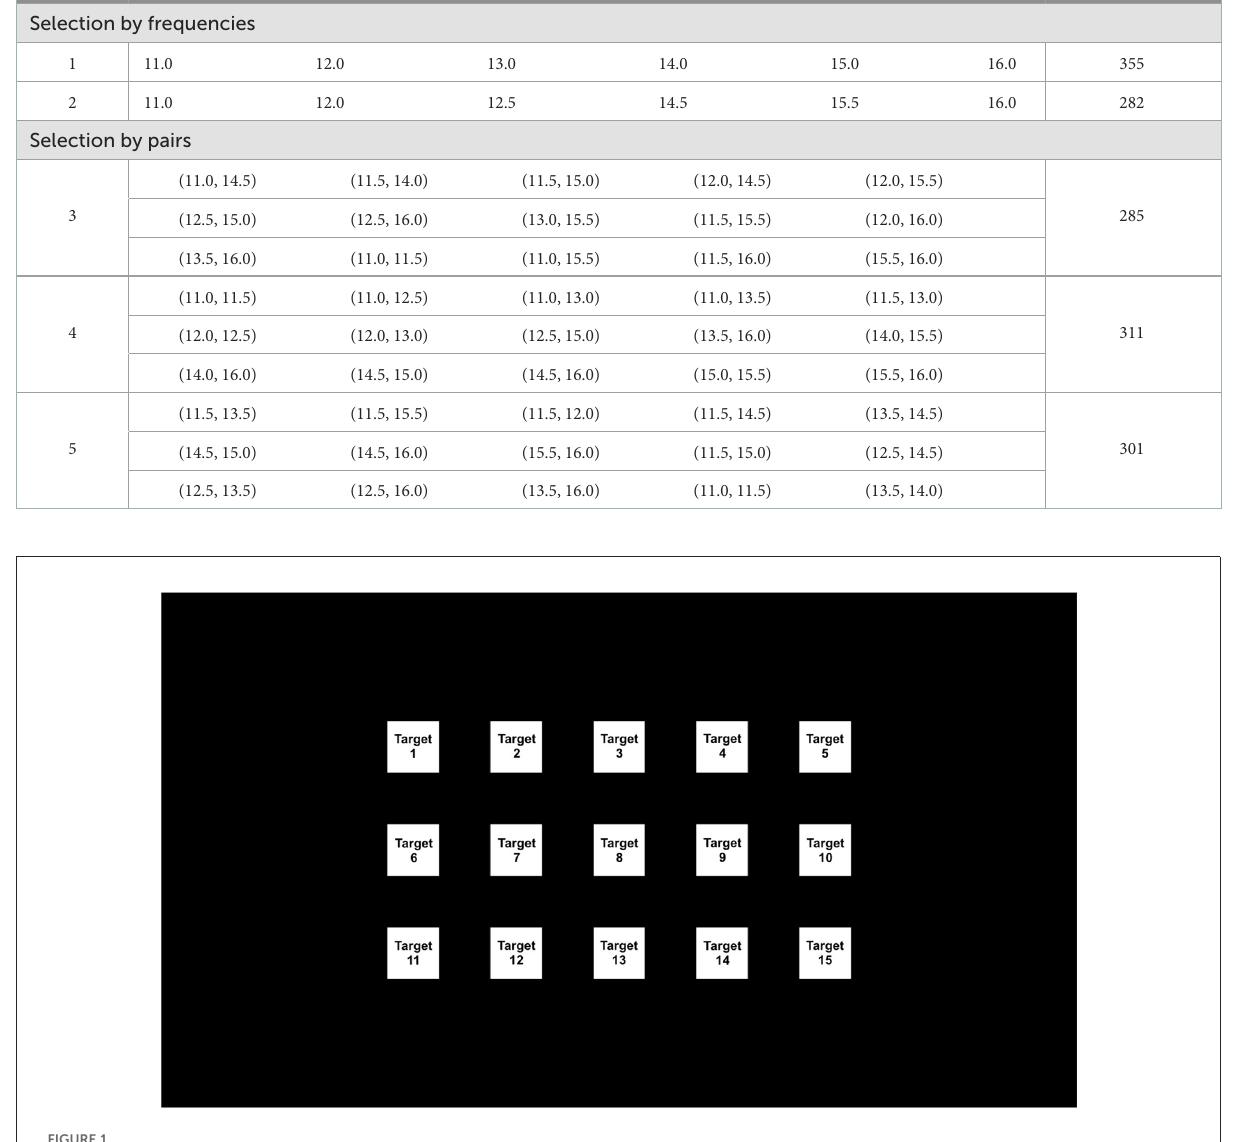
FIGURE1 Stimuli layout on the